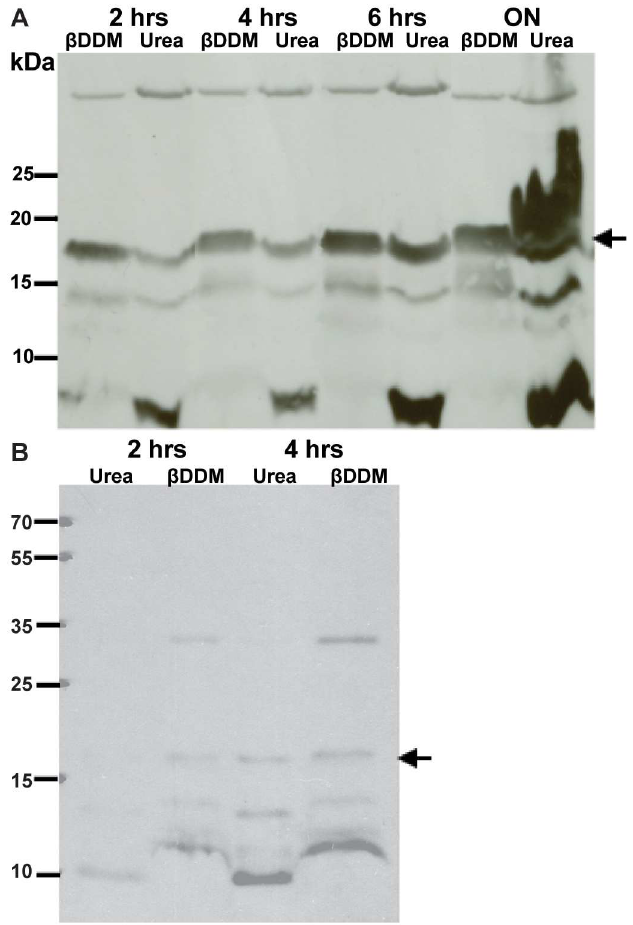
Fig 4. Vpu fractionates with the membrane fraction and inclusion bodies dependent on time post- induction with IPTG. The β DDM extractablefraction increaseswith time until it reaches saturation around6 hr ( A ). When the non-aqueous fraction is first treated with urea and then β DDM ( B ), the protein first fractionates in the detergent fraction, implyingthat protein does integrate in the membranes that is extractable by β DDM. Vpu is indicatedby a black